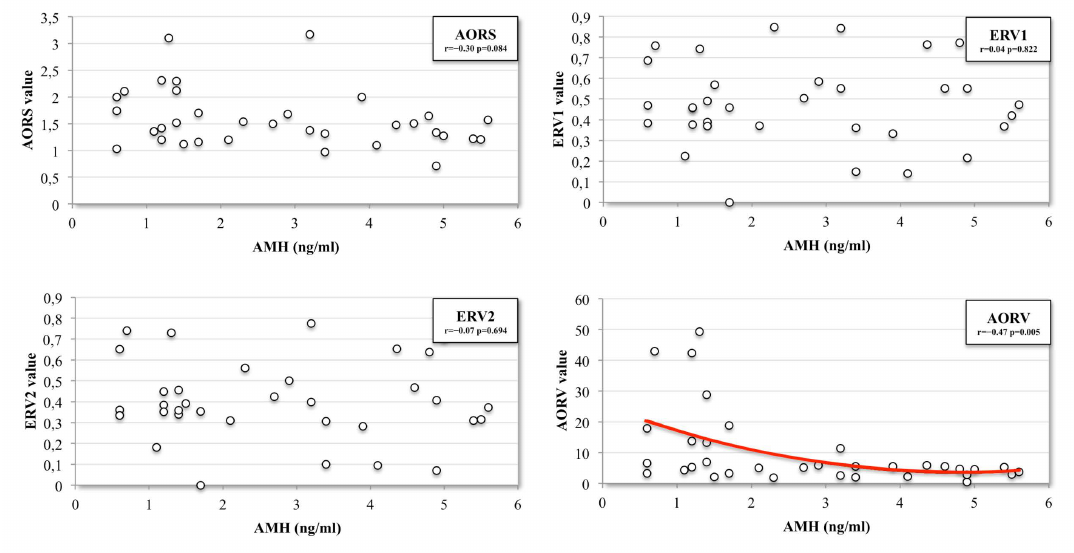
Figure 4. Scatterplots of the four relative sonographic indicators. Pearson’s correlation coe ffi cient ( r ) testing the strength of the association between the independent variable (AMH level) and the dependent variables (indicators), ranging from − 1 to + 1. AORS: a ff ected ovary relative size; AORV: a ff ected ovary relative volume; ERV1: endometrioma relative volume 1; ERV2: endometrioma relative volume